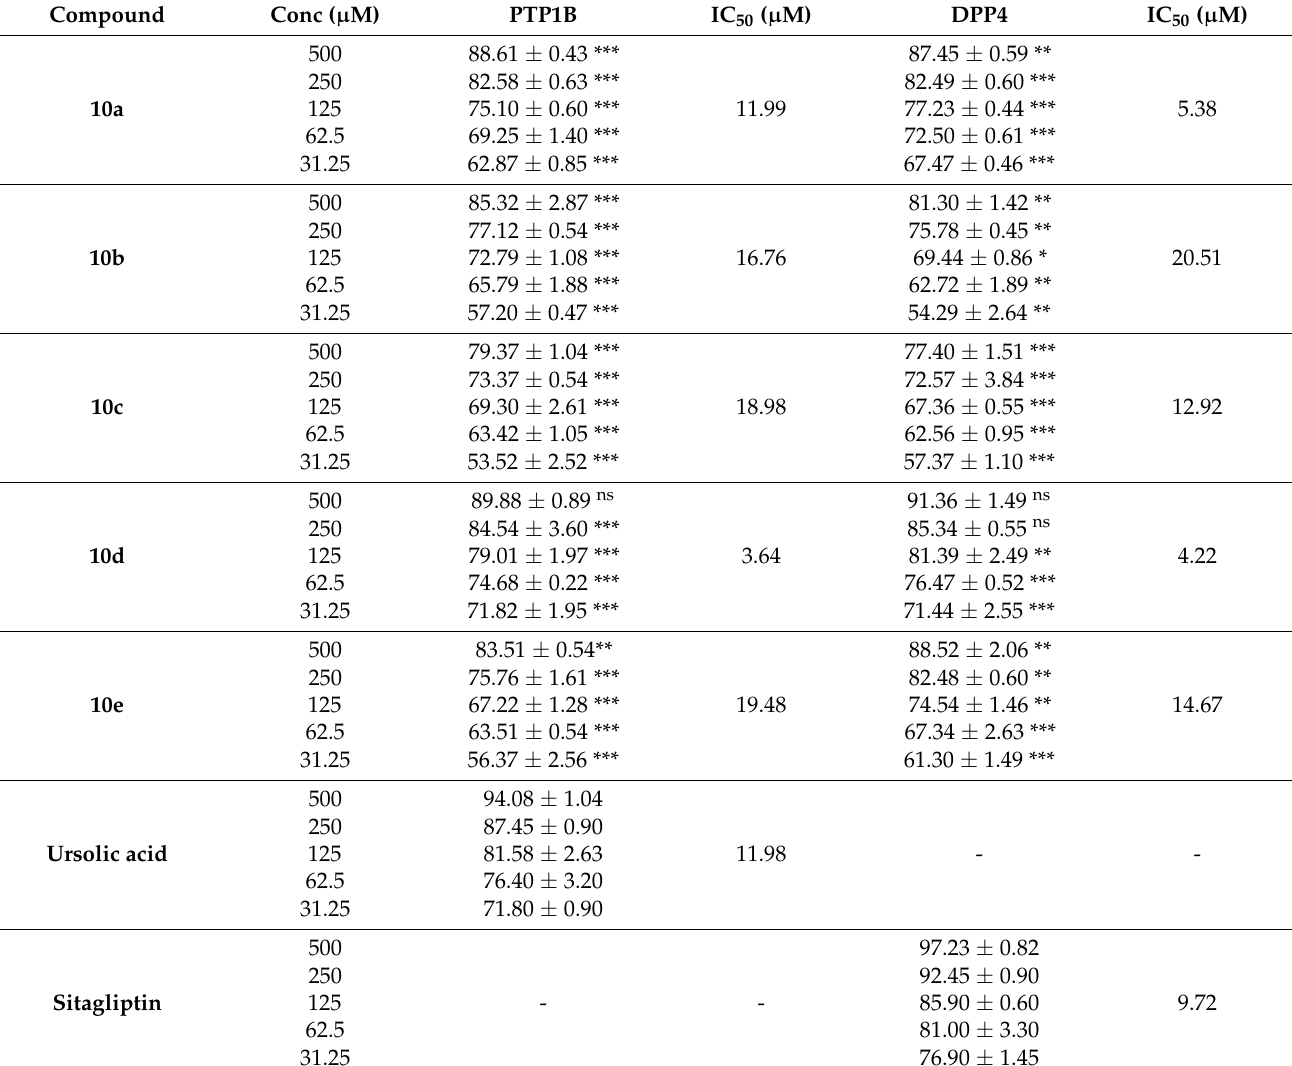
Table: the effect of tested compounds. The values were represented as mean ± SEM. * p < 0.05, ** p < 0.01, *** p < 0.001 and ns not significant compared to standard drugs. Data were analyzed via two-way ANOVA pursued by the Bonferroni